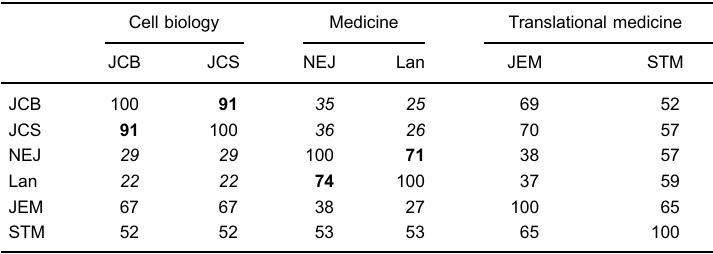
Table 2. Similarity indexes between vocabulary of title and abstracts of articles from cell biology, medicine, and translational journals. Cell